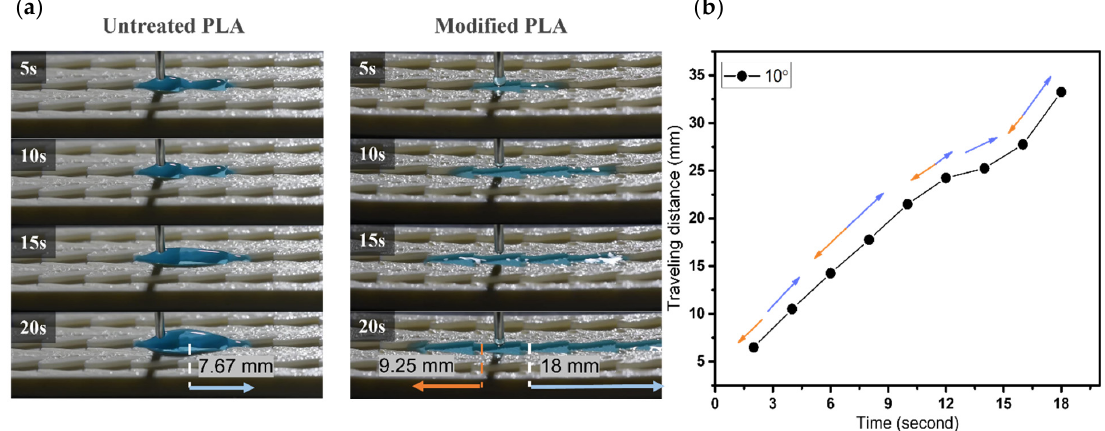
Figure 8. ( a ) The dynamic wetting behavior of water droplets in the 3D-printed dart-shaped pattern with α angle of 10 ° ; ( b ) Plot of traveling distance versus time with the directions of droplet movement wetting of modified pattern. The orange arrow denotes the opposite side, and the blue one denotes the predominant side.